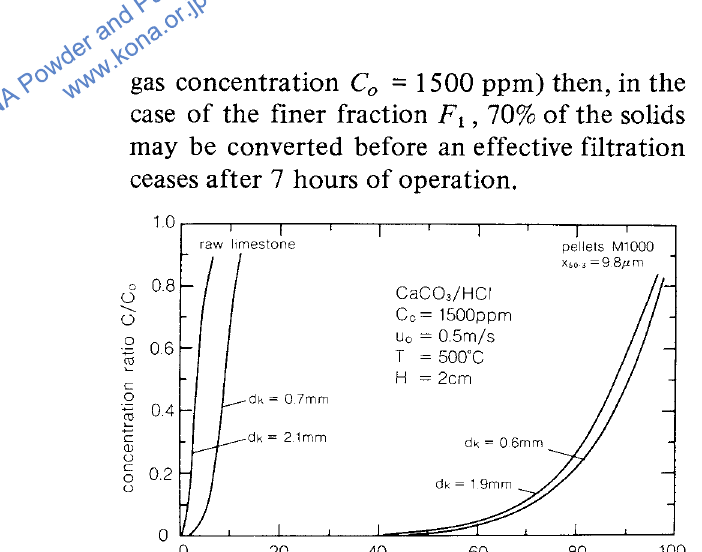
Fig. 5 Influence of the grain size on the breakthrough behaviour of HCl through ganular beds of raw limestone and limestone pellets at a tempera ture of 500°C (air as carrier medium)